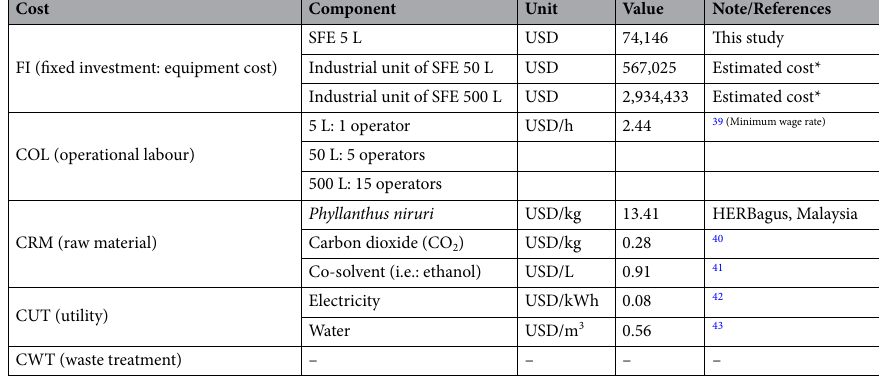
Table 4. Required parameter for economic analysis. *Calculated estimation cost by using Eq.